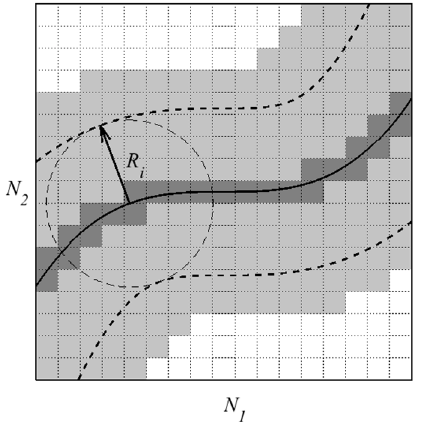
Figure 1. The interface and the elements in its